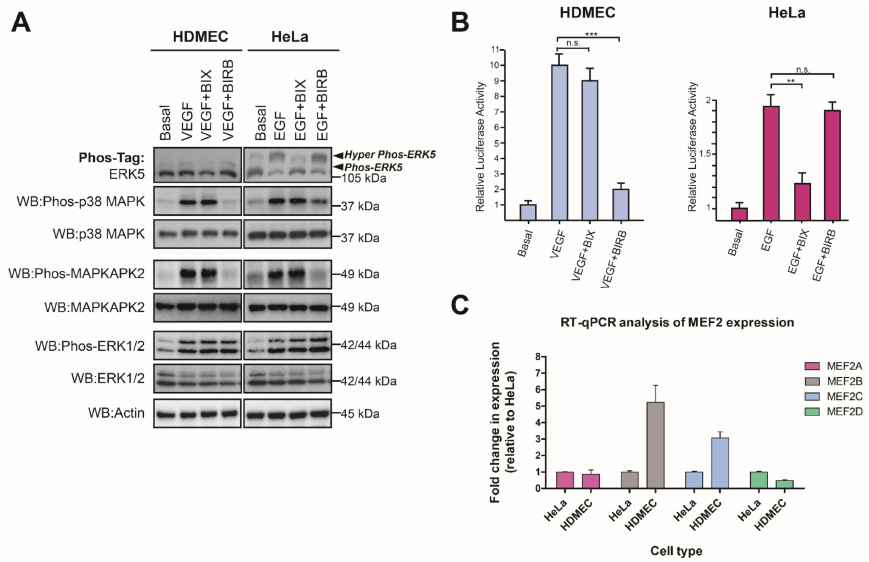
Figure 7. VEGF-mediated ERK5 activity is not required for MEF2 transcriptional activity in en- dothelial cells. ( A ) HDMECs and HeLa cells were serum-starved overnight and then treated with either vehicle control (0.1% DMSO) or the MEK5 inhibitor BIX02189 (BIX; 1 µ M) or the p38 MAPK inhibitor BIRB796 (BIRB; 1 µ M), for 1 h prior to stimulation with VEGF (50 ng/mL) or EGF (50 ng/mL) for 10 min. Cells were lysed in RIPA buffer, and lysates were resolved by 10% SDS-PAGE or